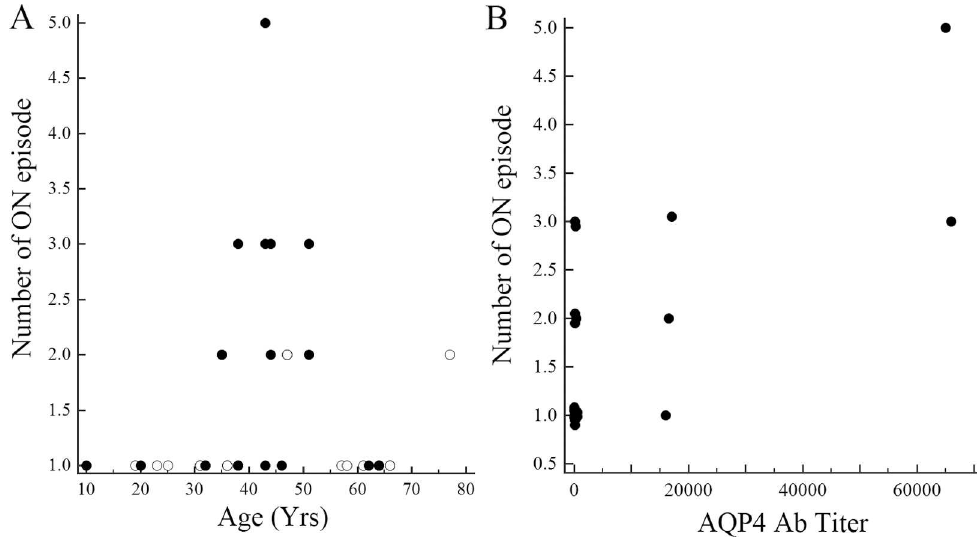
Fig 2. Scatter plots of number of optic neuritis (ON) episodes against age (A) and titer of the anti- aquaporin 4 autoantibody (AQP4 Ab) (B). Open circles indicateeyes with AQP4 Ab-negativeON, whereas closed circles indicate those with antibody-positive ON. Spearman rank correlationcoefficient (95% confidence interval, P-value) between numberof ON episodes and AQP4 Ab titer was 0.46 (0.02 to 0.75,